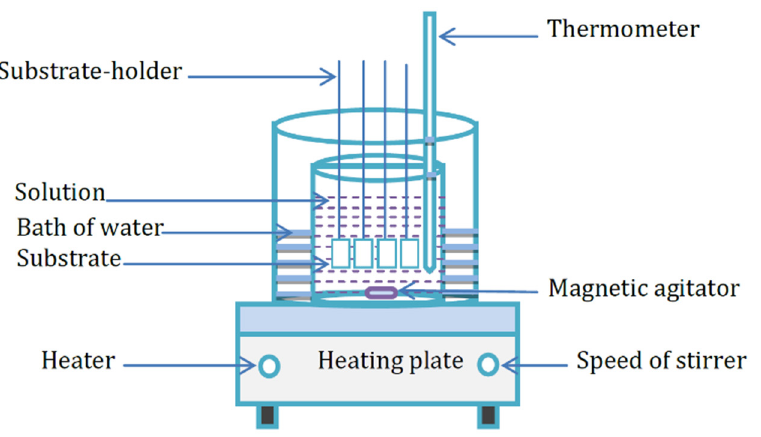
Figure 1. Chemical bath deposition system.